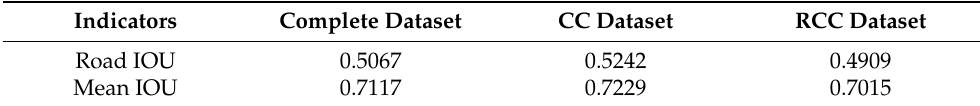
Table 2. Applying RCCA module to different datasets.